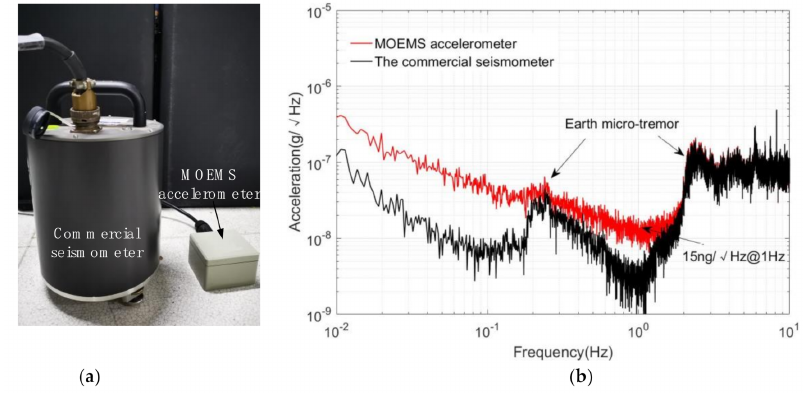
Figure 13. ( a ) Calibrating the self-noise of the MEMS accelerometer with a commercial seismometer for reference. ( b ) The power spectral density (PSD) of the output of the MOEMS accelerometers and the commercial